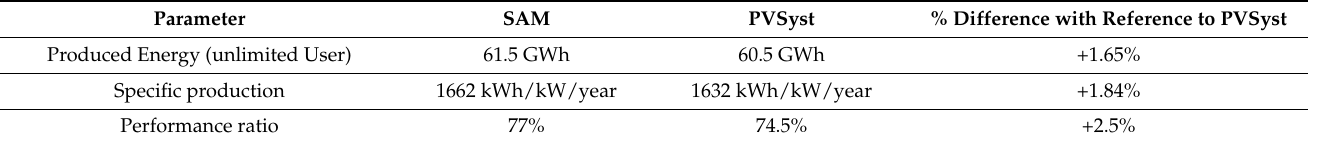
Table 14. Comparison between PVSyst and SAM.